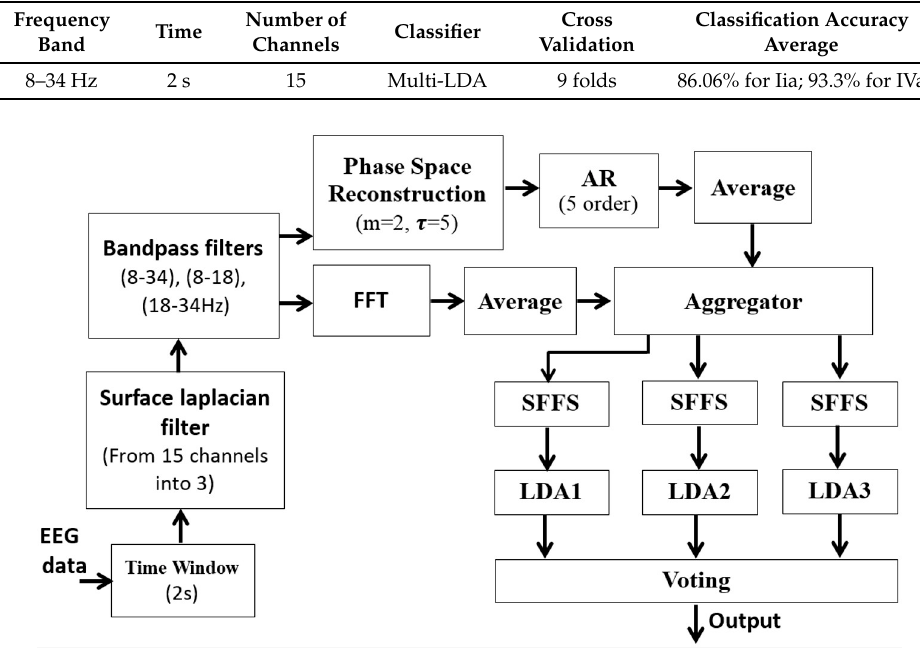
Table 9. The final classification results.